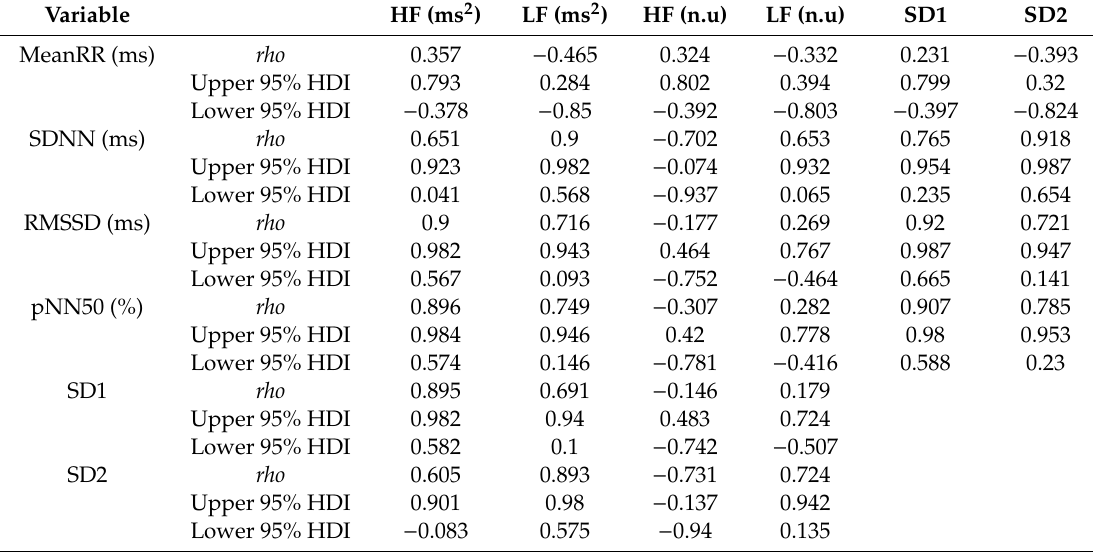
Table 6. Correlation matrix between HRV measures from time domain, frequency domain and nonlinear domain.